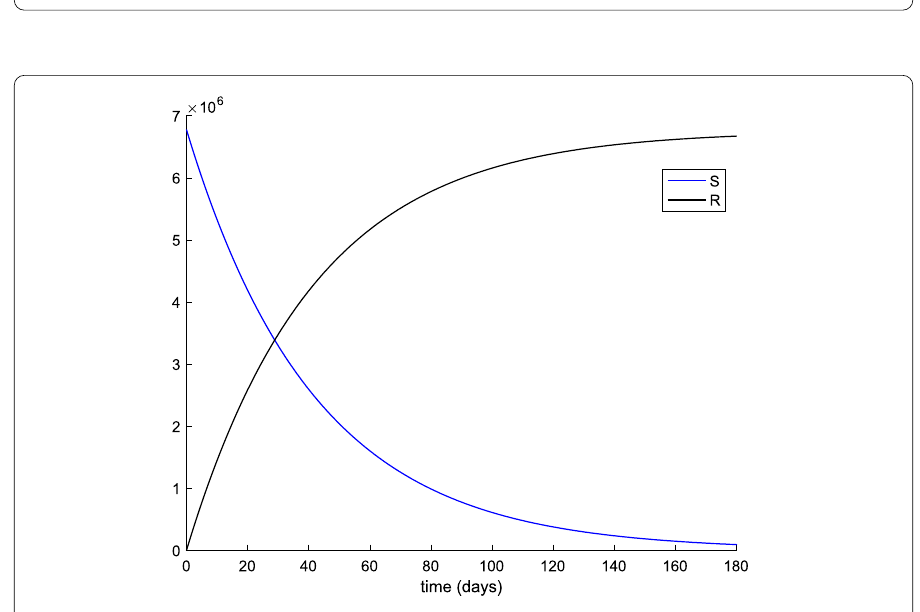
Figure 12 Evolution of Susceptible and Immune when vaccination and treatment are applied with k V = 0.001 and k T =